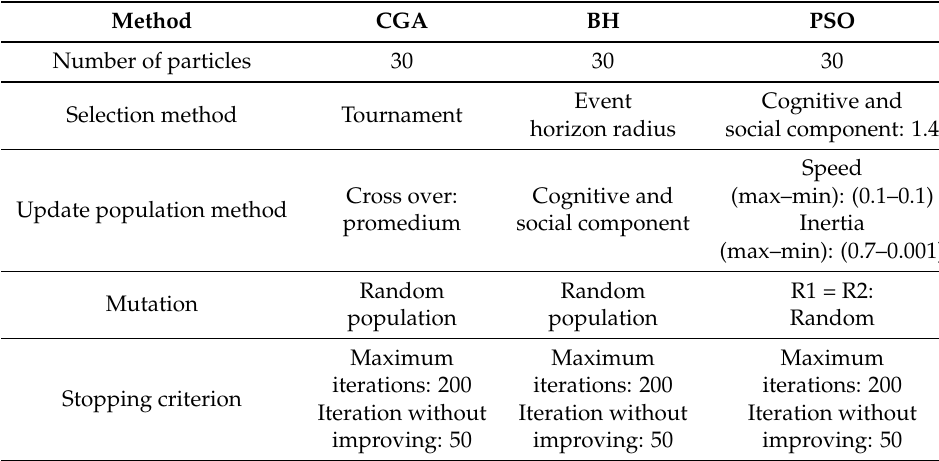
Table 4. Parameters of the sizing techniques.